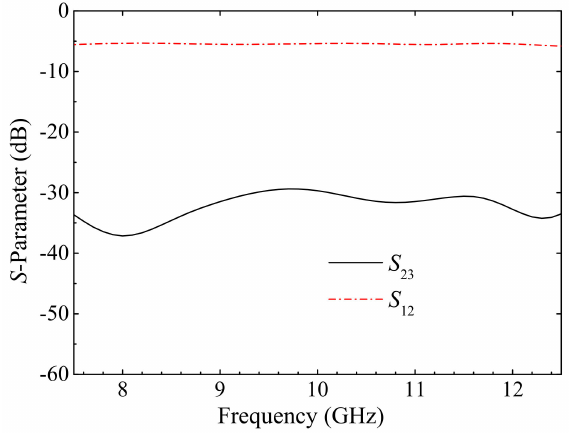
Figure 12. Simulated S -parameter of antenna with separate four-port feed.